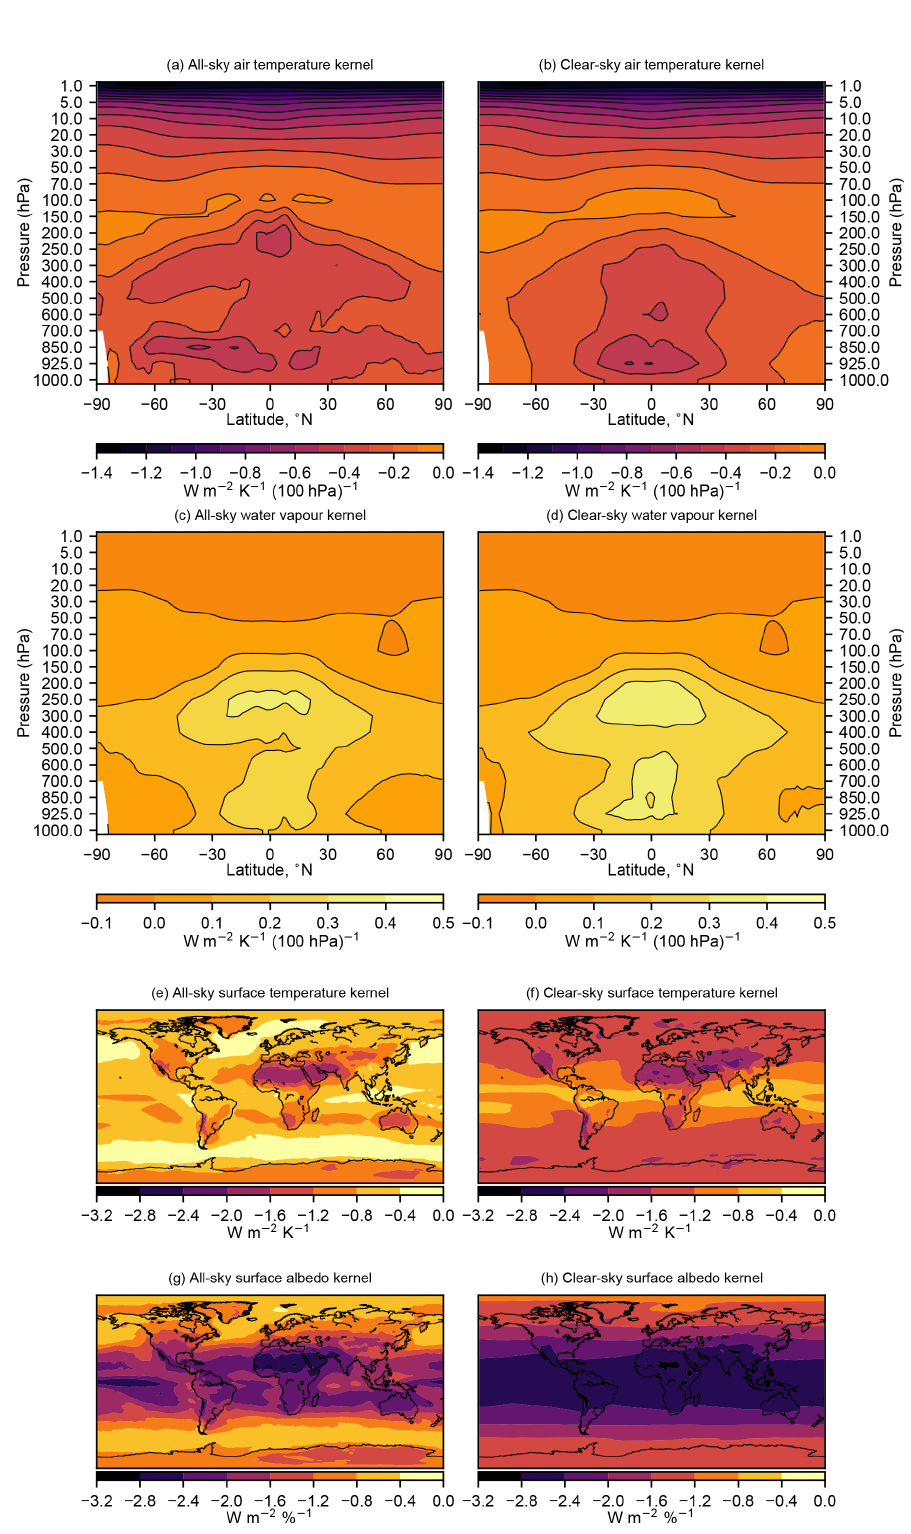
Figure 1. Top-of-atmosphere radiative kernels from HadGEM3-GA7.1.